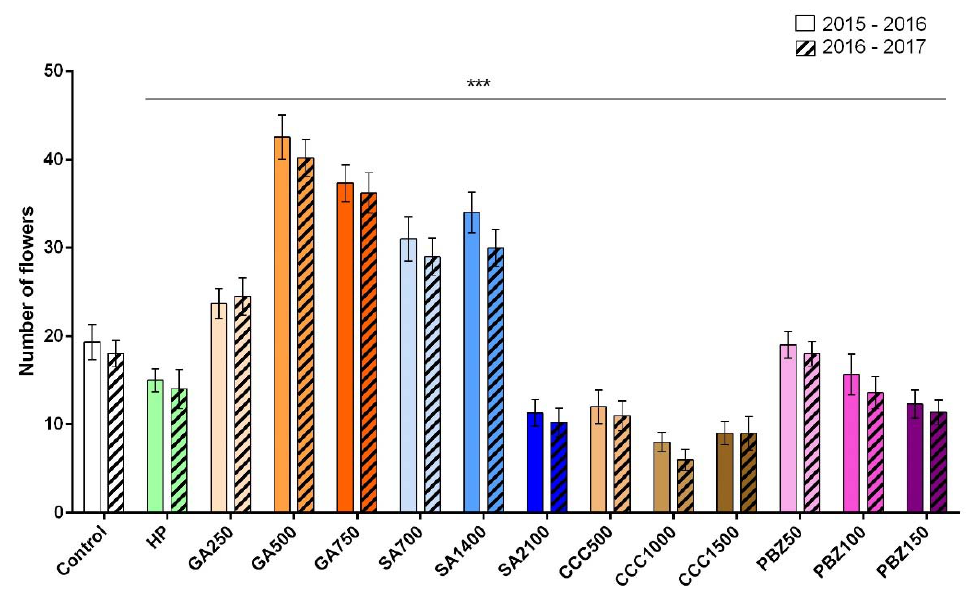
Figure 1. Effects of saffron corm priming with distilled water and four different growth regulators on flower numbers per m 2 grown under field condition. HP, hydropriming; GA, gibberellic acid; SA, salicylic acid; CCC, chlormequat chloride; PBZ, paclobutrazol. Data are shown as mean ± standard deviation; *** p < 0.001 vs. control group. The empty white and colored columns correspond to the data for the years 2015–2016. The white and colored columns with oblique lines correspond to the years 2016–2017.